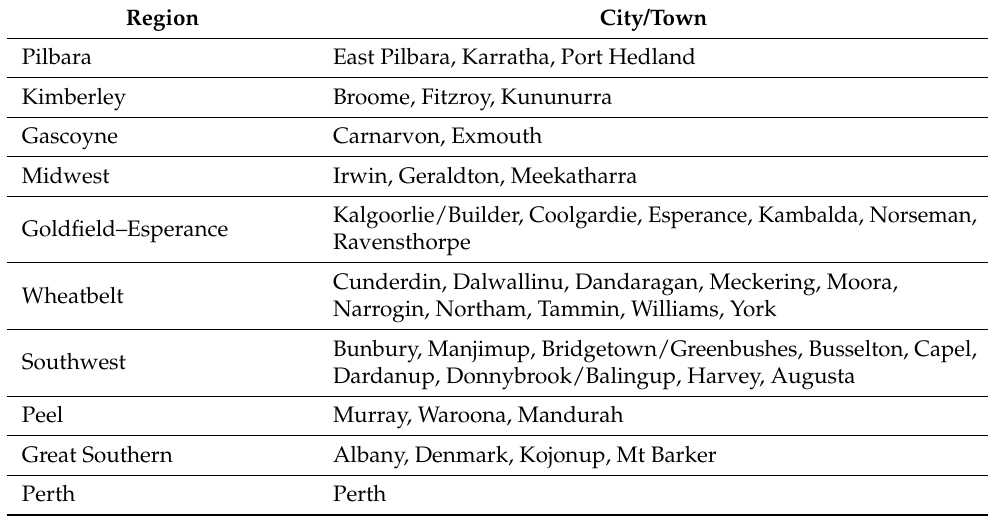
Table 1. Western Australian